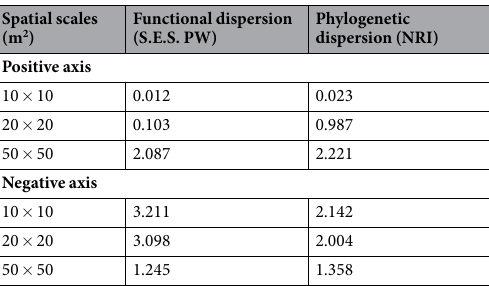
Table 2. Phylogenetic and functional dispersion patterns at three spatial